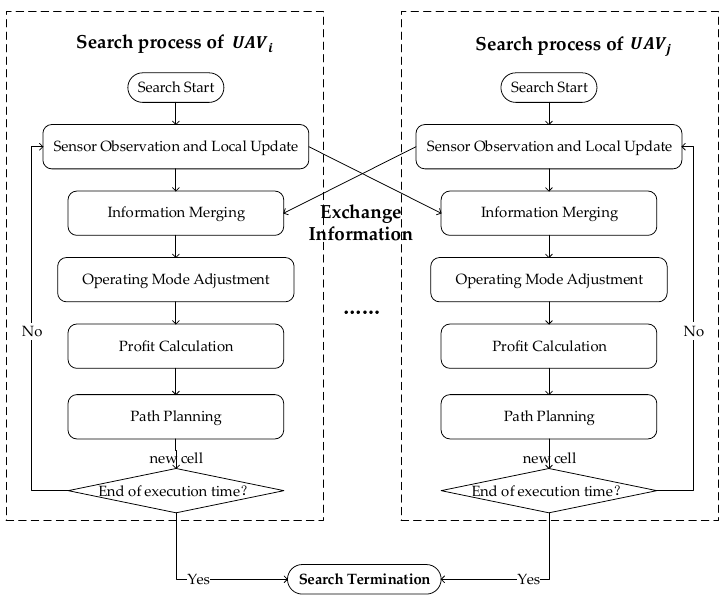
Figure 3. The framework of